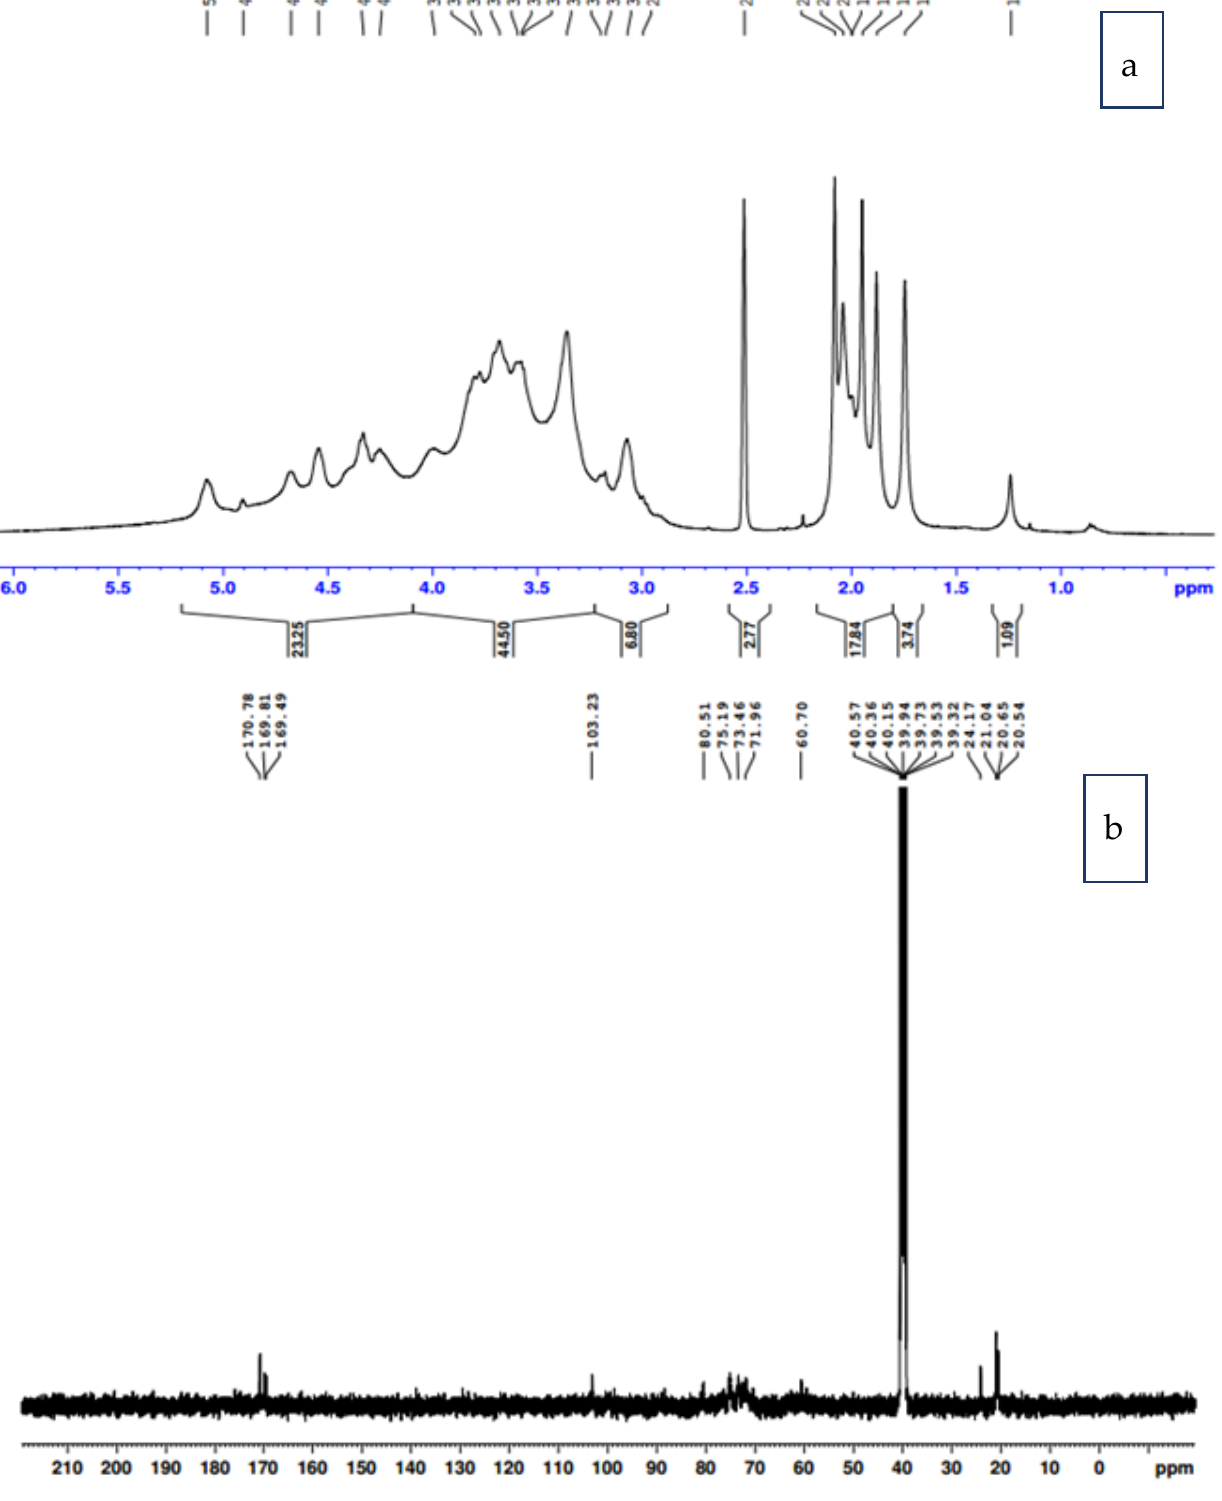
Figure 3. ( a ) 1 H NMR spectrum of chloroform soluble CA palm fronds ( b ) 13 C NMR spectrum of chloroform soluble CA palm fronds.